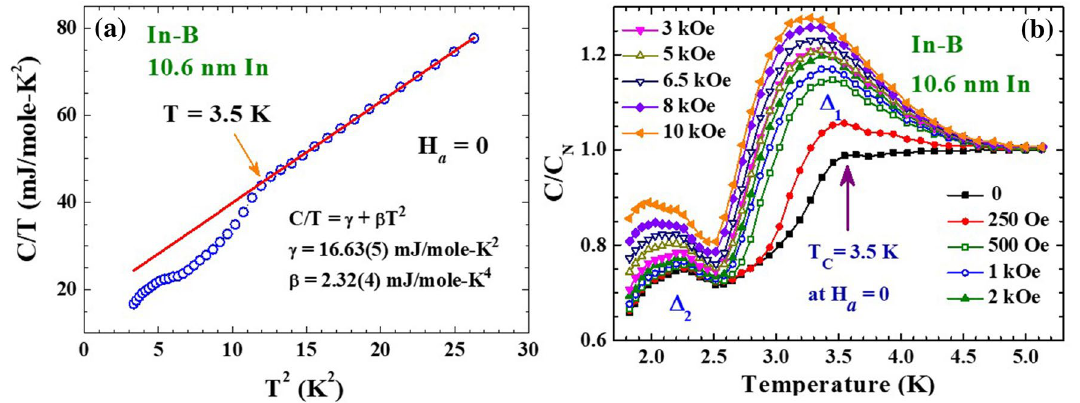
Figure 4. ( a ) C/T vs T 2 plot of the specific heat of the 10.6 nm In nanoparticles. The solid curve shows the results of the fit of the data at high temperatures to the expression listed in the plot. The specific heat departs from the γT + βT 3 behavior below 3.5 K. ( b ) Electronic specific heat of the 10.6 nm In nanoparticles measured under various applied magnetic field, revealing a two-peak structure, labelled Δ 1 and Δ 2